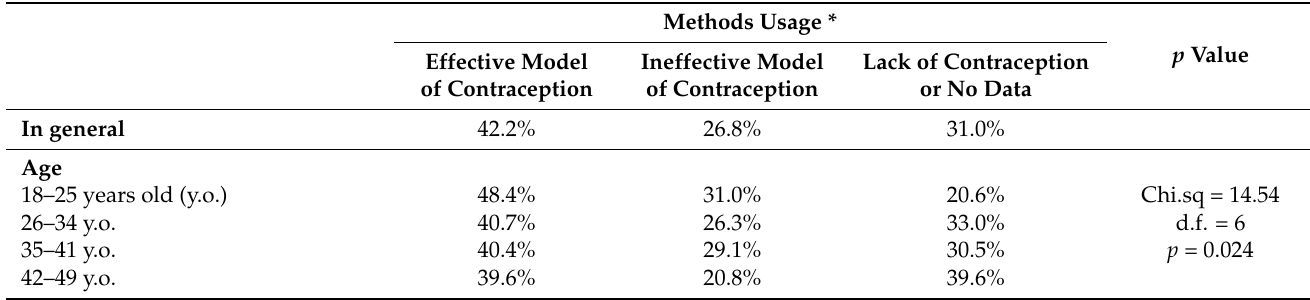
Table 3. Usage of contraceptive methods according to selected characteristics of the